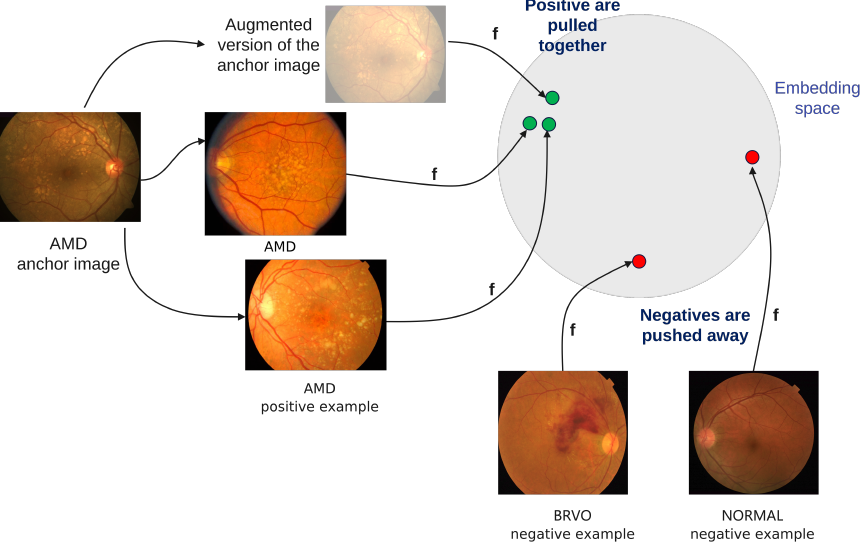
Figure 1. Supervised contrastive